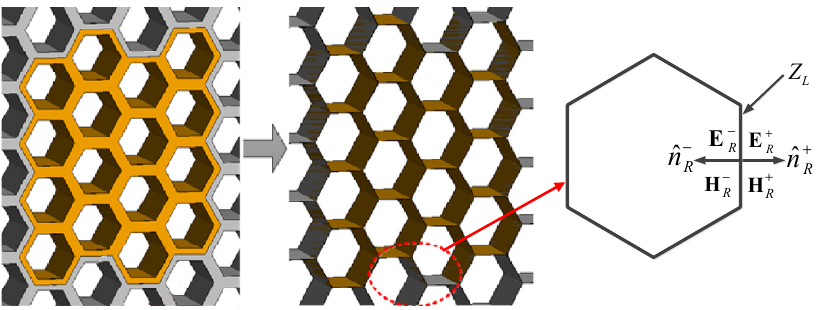
Figure 2. RSBC model of the honeycomb’s thin wall.